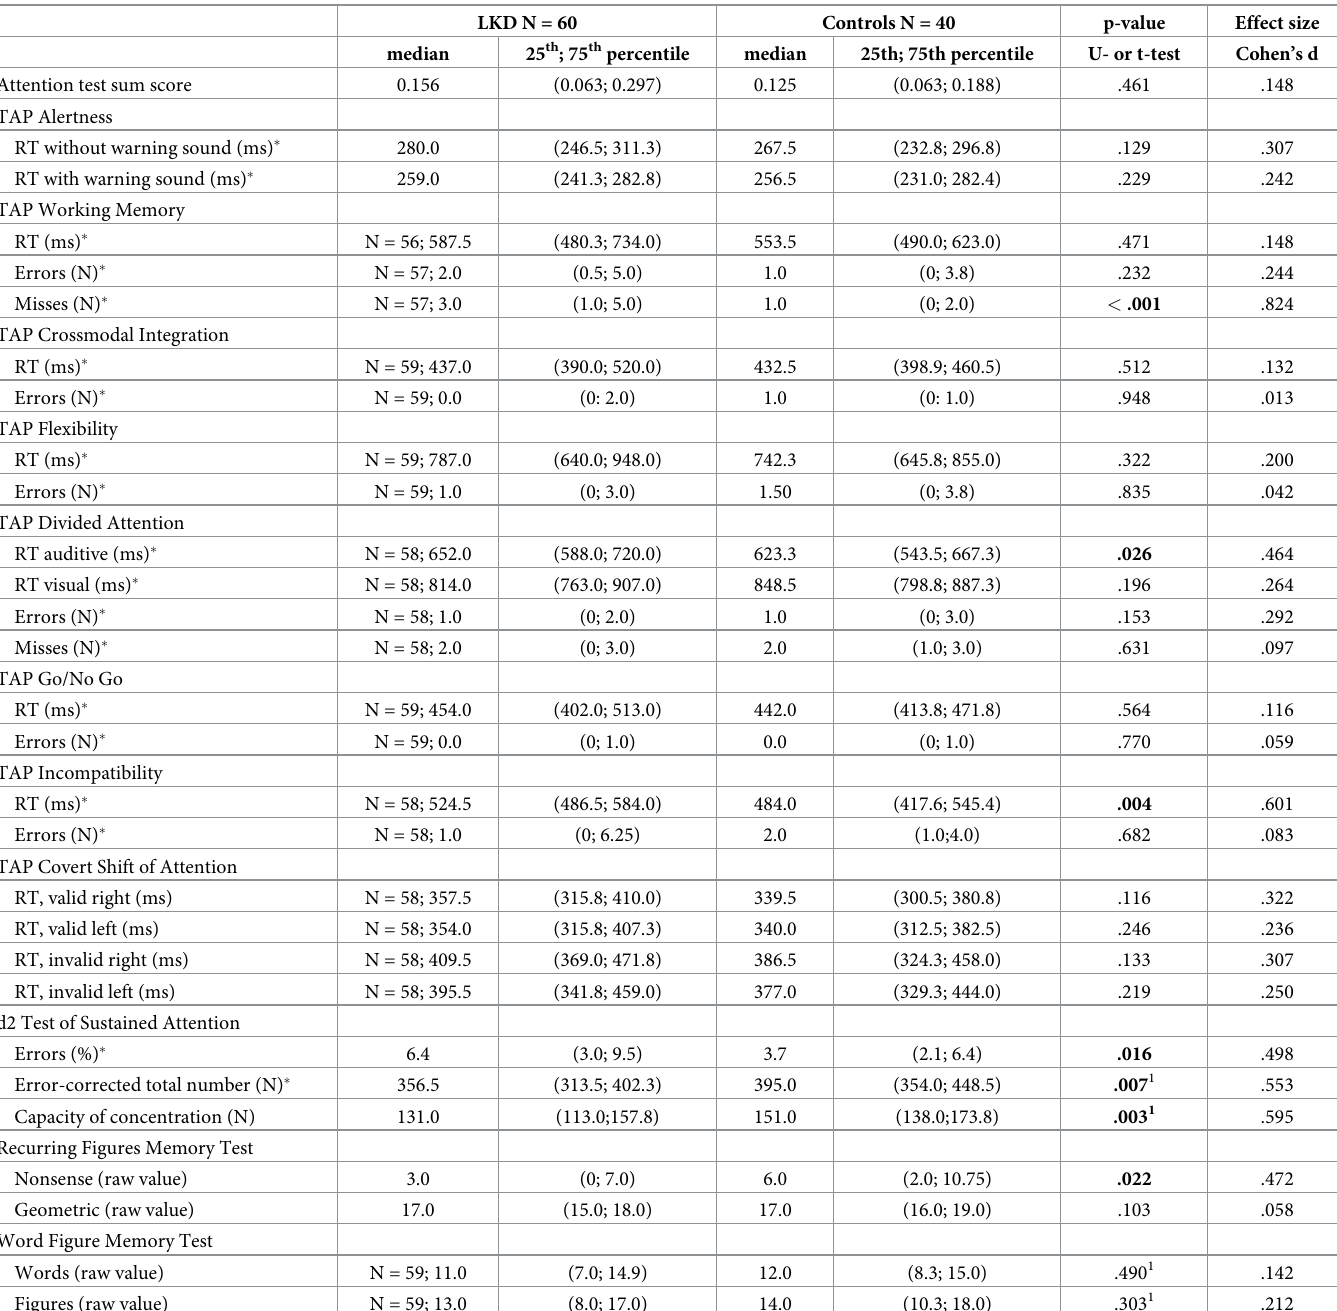
Table 2. Comparison of cognitive test results between living kidney donors (LKD) and